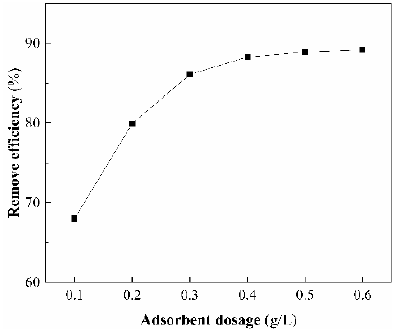
Figure 8. Effect of adsorbent dosage on the As( Ⅴ ) removal. Figure 8. E ff ect of adsorbent dosage on the As(V)